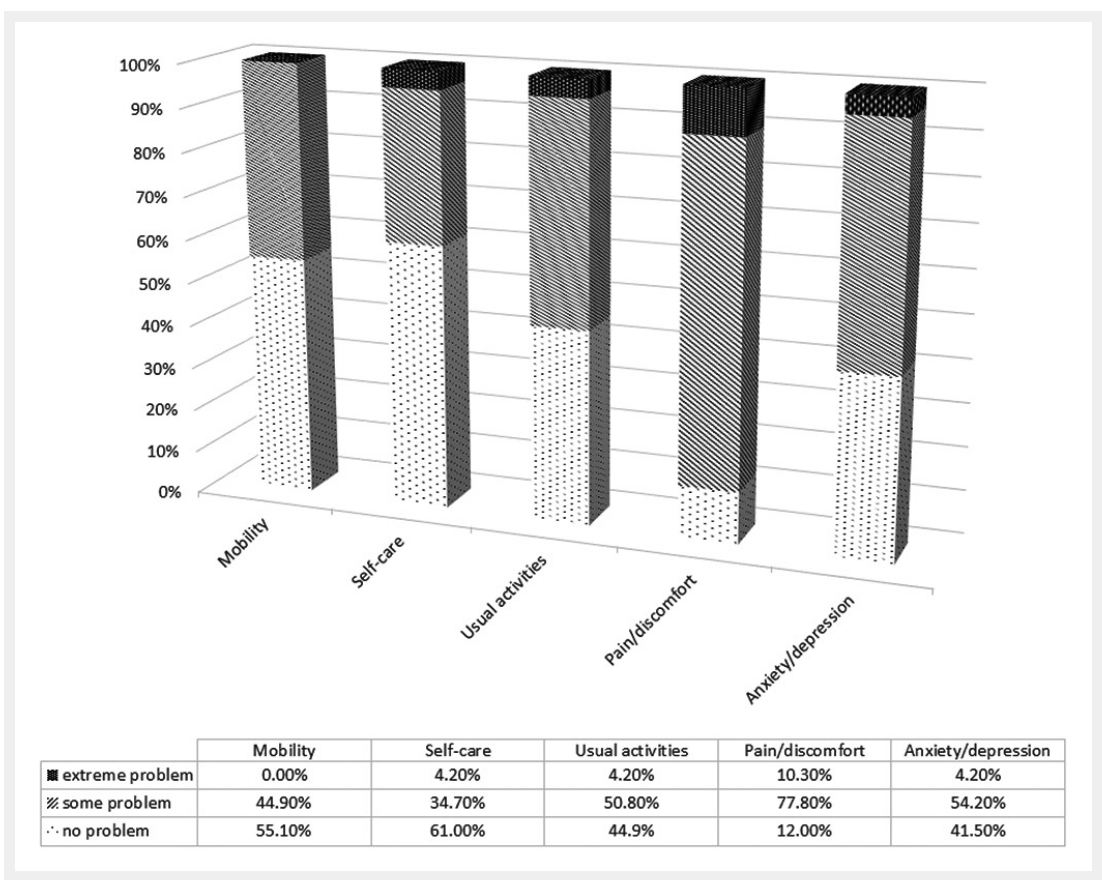
Figure 2 Health assessment questionnaire (HAQ)health